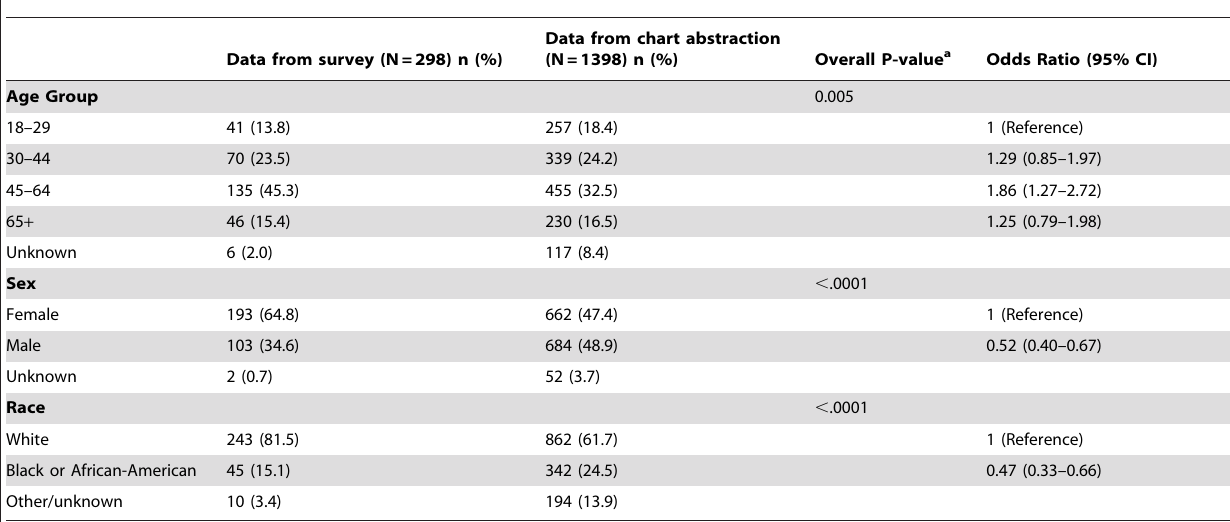
Table 2. Demographic characteristics of patients whose hospital charts were abstracted, and of survey participants.